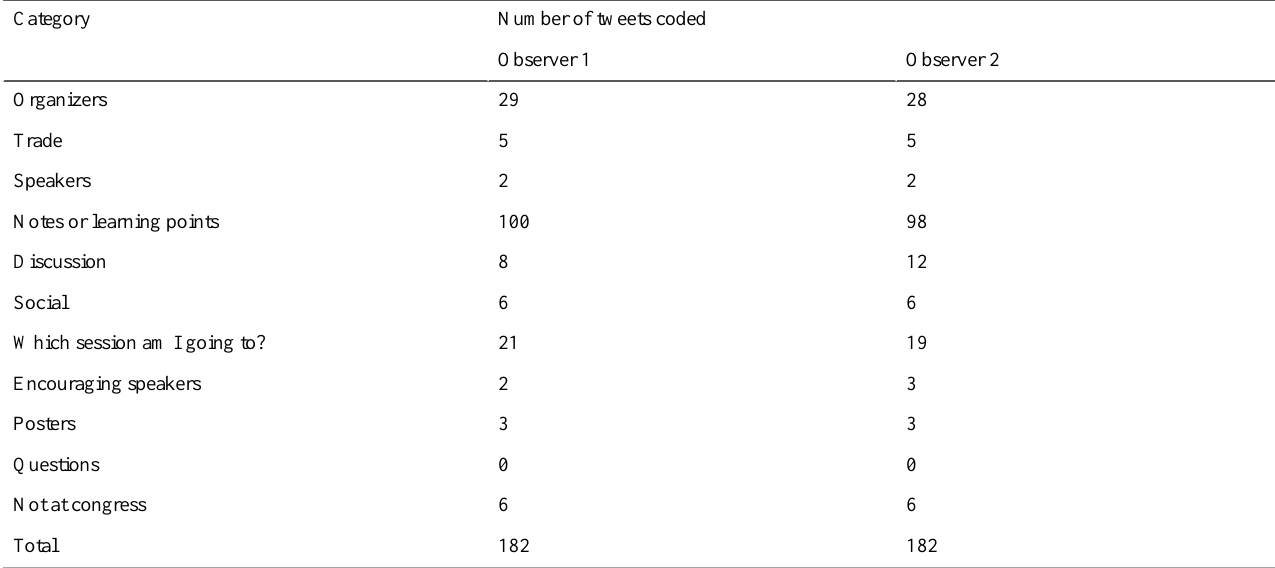
Table 4. Interobserver reliability of the different uses of Twitter during the